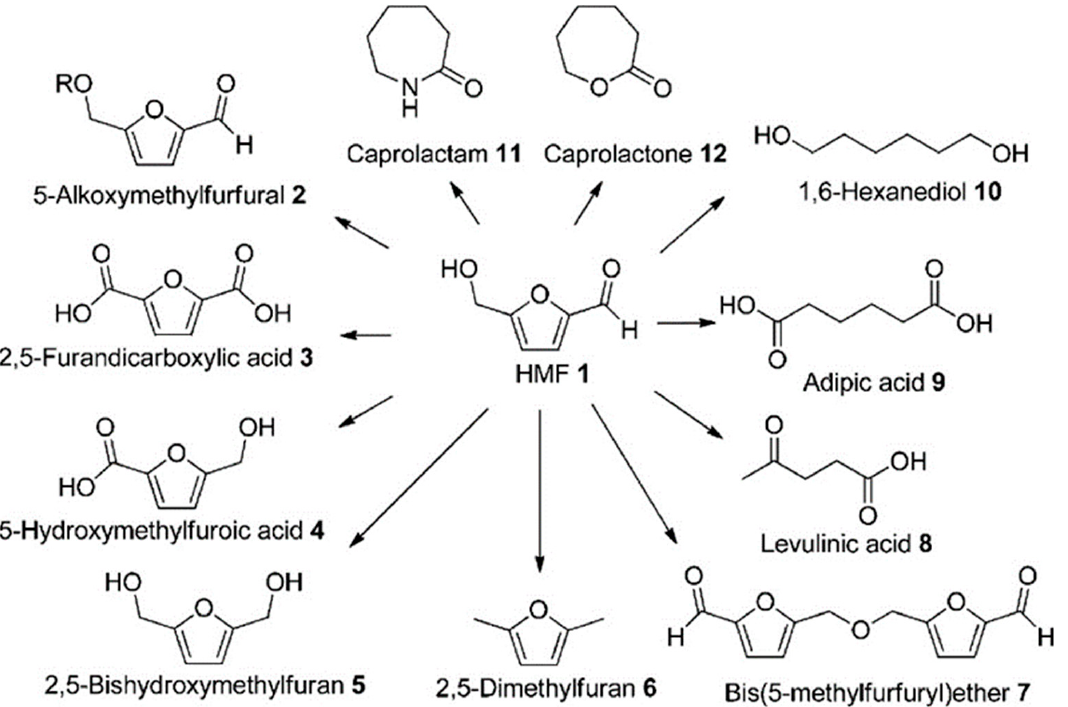
Figure 7. 5-Hydroxymethylfurfural as a platform molecule. Reproduced with permission from ref. [103] Copyright © 2013 American Chemical Society.